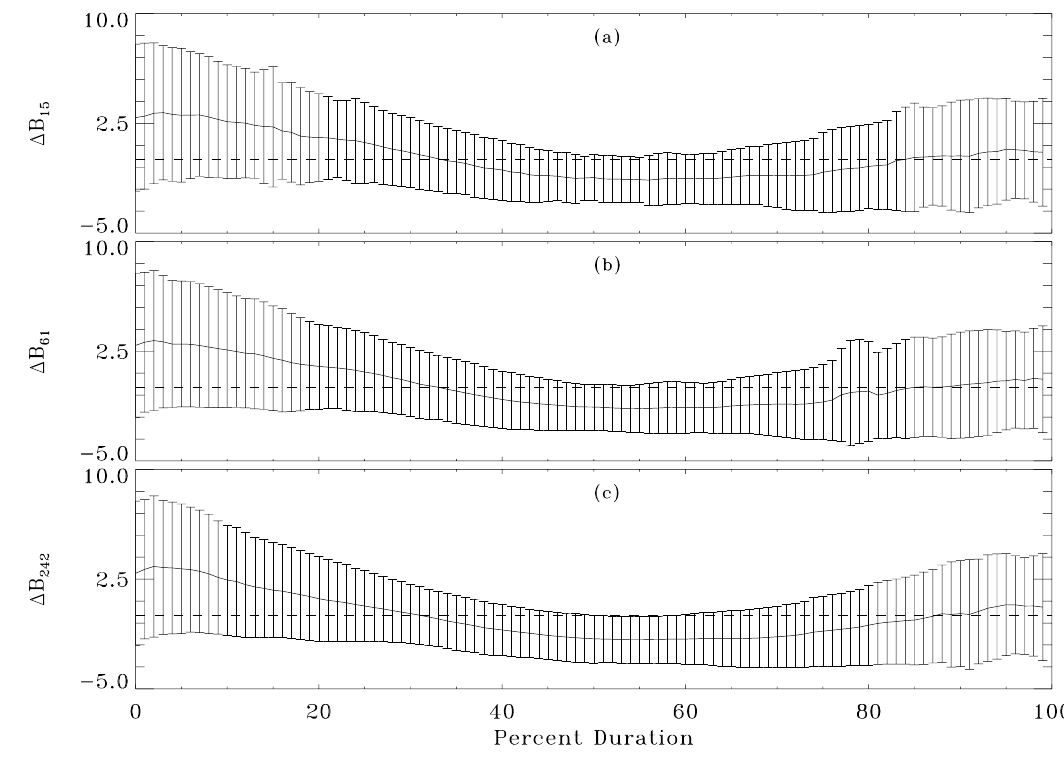
Fig. 2. Family of plots of 1B (= B obs − B mod ) vs. %-duration for three 1T s (from top to bottom as in Fig. 1a, b, c, as shown by the subscripts on the 1 Bs on the left). The central curves are the actual averages over the 50 MCs, and the lengths (top-to-bottom) of the vertical bars at the points represent twice their sigmas. The dashed line is the